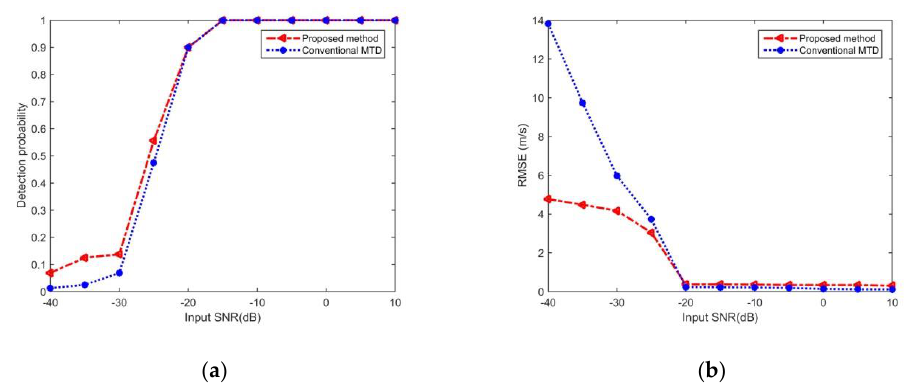
Figure 4. Performance comparison: ( a ) Detection probability over input SNR; ( b ) Speed estimation error over input SNR.